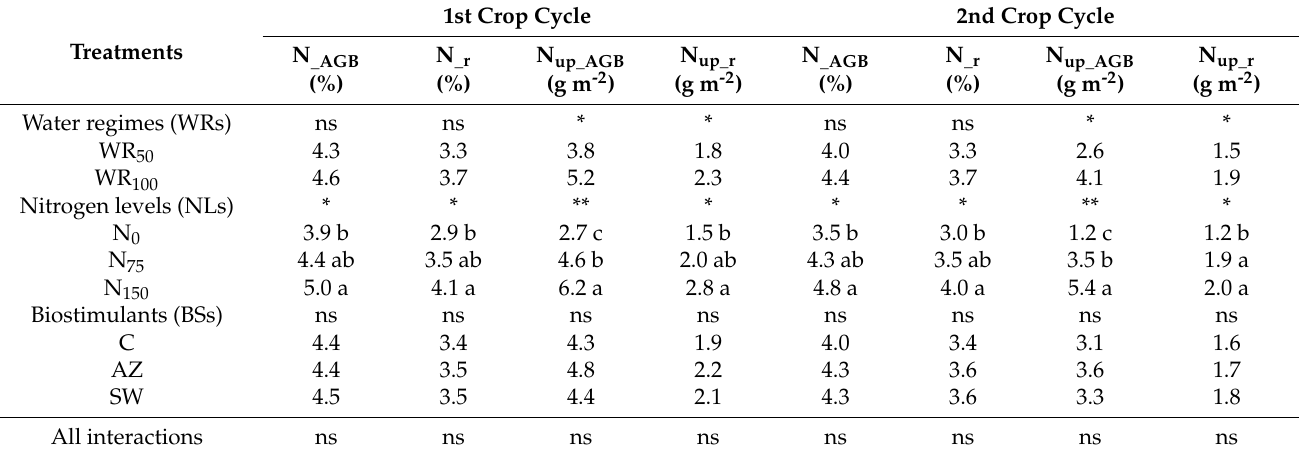
Table 2. Effect of water regime, nitrogen level, and the application of biostimulants on the total N content of above ground biomass (N _AGB ) and roots (N _r ) and on the N uptake of above ground biomass (N up_AGB ) and roots (N up_r ) of wild rocket for the two crop cycles. WR 100 = restoration of 100% of ETc, WR 50 = restoration of 50% of ETc; N 0 = 0 kg ha − 1 of N, N 75 = 75 kg ha − 1 of N, N 150 = 150 kg ha − 1 of N; C = control; AZ = application of azoxystrobin; SW = application of a seaweed extract-based